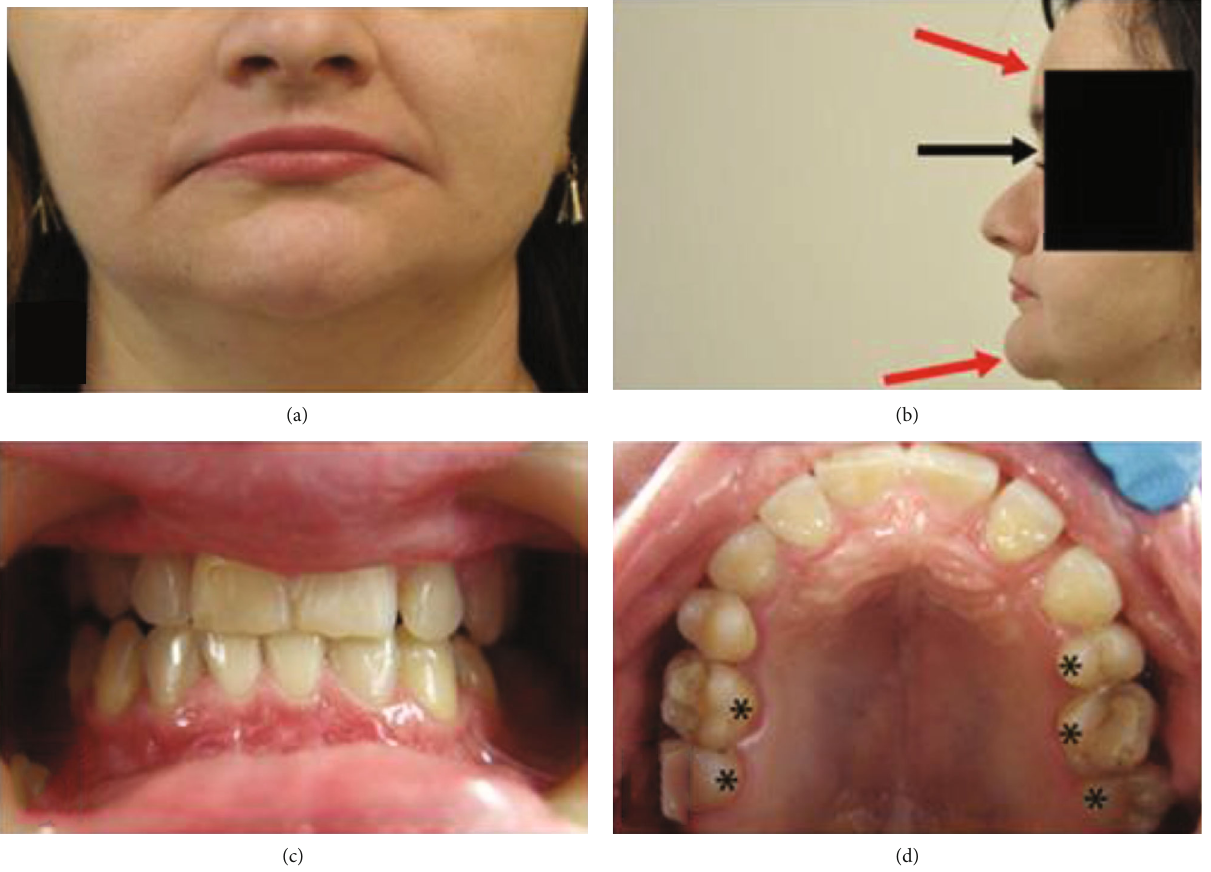
Figure 1: A 29-year-old patient with CCD. (a) Frontal view shows lowering corners of mouth and vermilion as well as deepening nasal-lip and chin wrinkles. (b) Pro fi le view shows depressed nasal bridge (black arrow), frontal bossing, and prominent chin (red arrow). (c) Intraoral view before treatment shows disturbed proportions between height and width of maxillary anterior teeth with signs of tooth wear on incisal edges and posterior (right side) open bite. (d) Intraoral occlusal view of maxillary arch before treatment reveals gaps between teeth 21, 22, and 23. Tooth germs 15 and 25 are missing. Caries lesions in posterior teeth were noticed and had to be treated before placing overlays (asterisk).